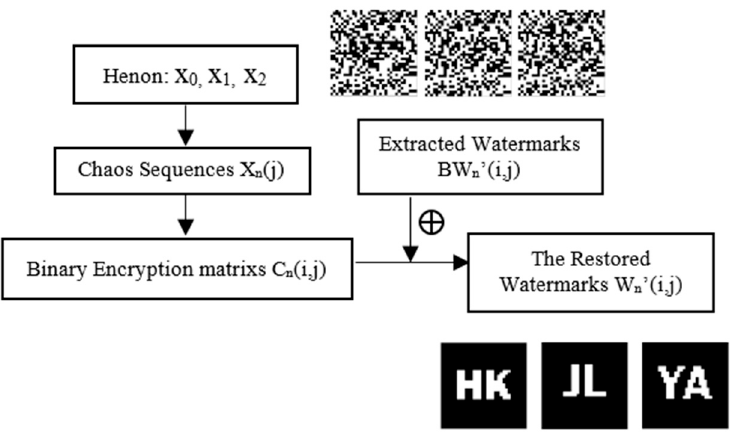
Figure 12. Watermarks restoration algorithm.